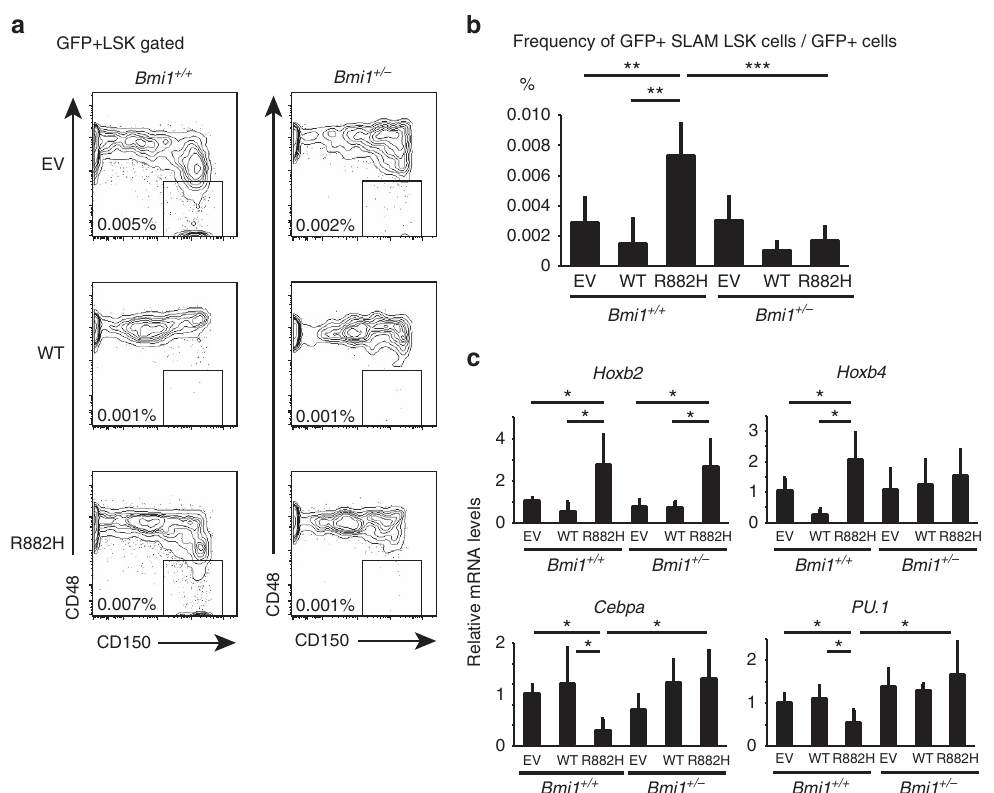
Figure 4 | PRC1 is crucial for DNMT3A mutant-induced HSC accumulation via silencing of differentiation-related genes. ( a ) Representative flow cytometric data of BM cells obtained from mouse transplanted with Bmi1 þ / þ (left) or Bmi1 þ / (cid:2) (right) cells transduced with EV, WTor R882H. The boxed region shows the frequency of GFP þ SLAM LSK cells in GFP þ cells. ( b ) Cumulative data of the frequency of GFP þ SLAM LSK cells in GFP þ cells. (EV and R882H: N ¼ 6; WT: N ¼ 4 mice.) P values were calculated using two-tailed unpaired t -test. ( c ) Relative expression levels of various haematopoiesis-associated genes in GFP þ KSL cells measured by qPCR. (EV and R882H: N ¼ 5; WT: N ¼ 3 replicate experiments, normalized to the expression levels in EV-transduced LSK cells.) P values were calculated using two-tailed unpaired t -test. BM, bone marrow; EV, empty vector; HSC, haematopoietic stem cell; PRC1, polycomb repressive complex1; qPCR; quantitative PCR; SLAM LSK, CD150 þ , CD48 (cid:2) , Lineage (cid:2) , Sca1 þ , c-kit þ ; WT, wild type. Data are mean ± s.d. values. * P o 0.05, ** P o 0.01, *** P o